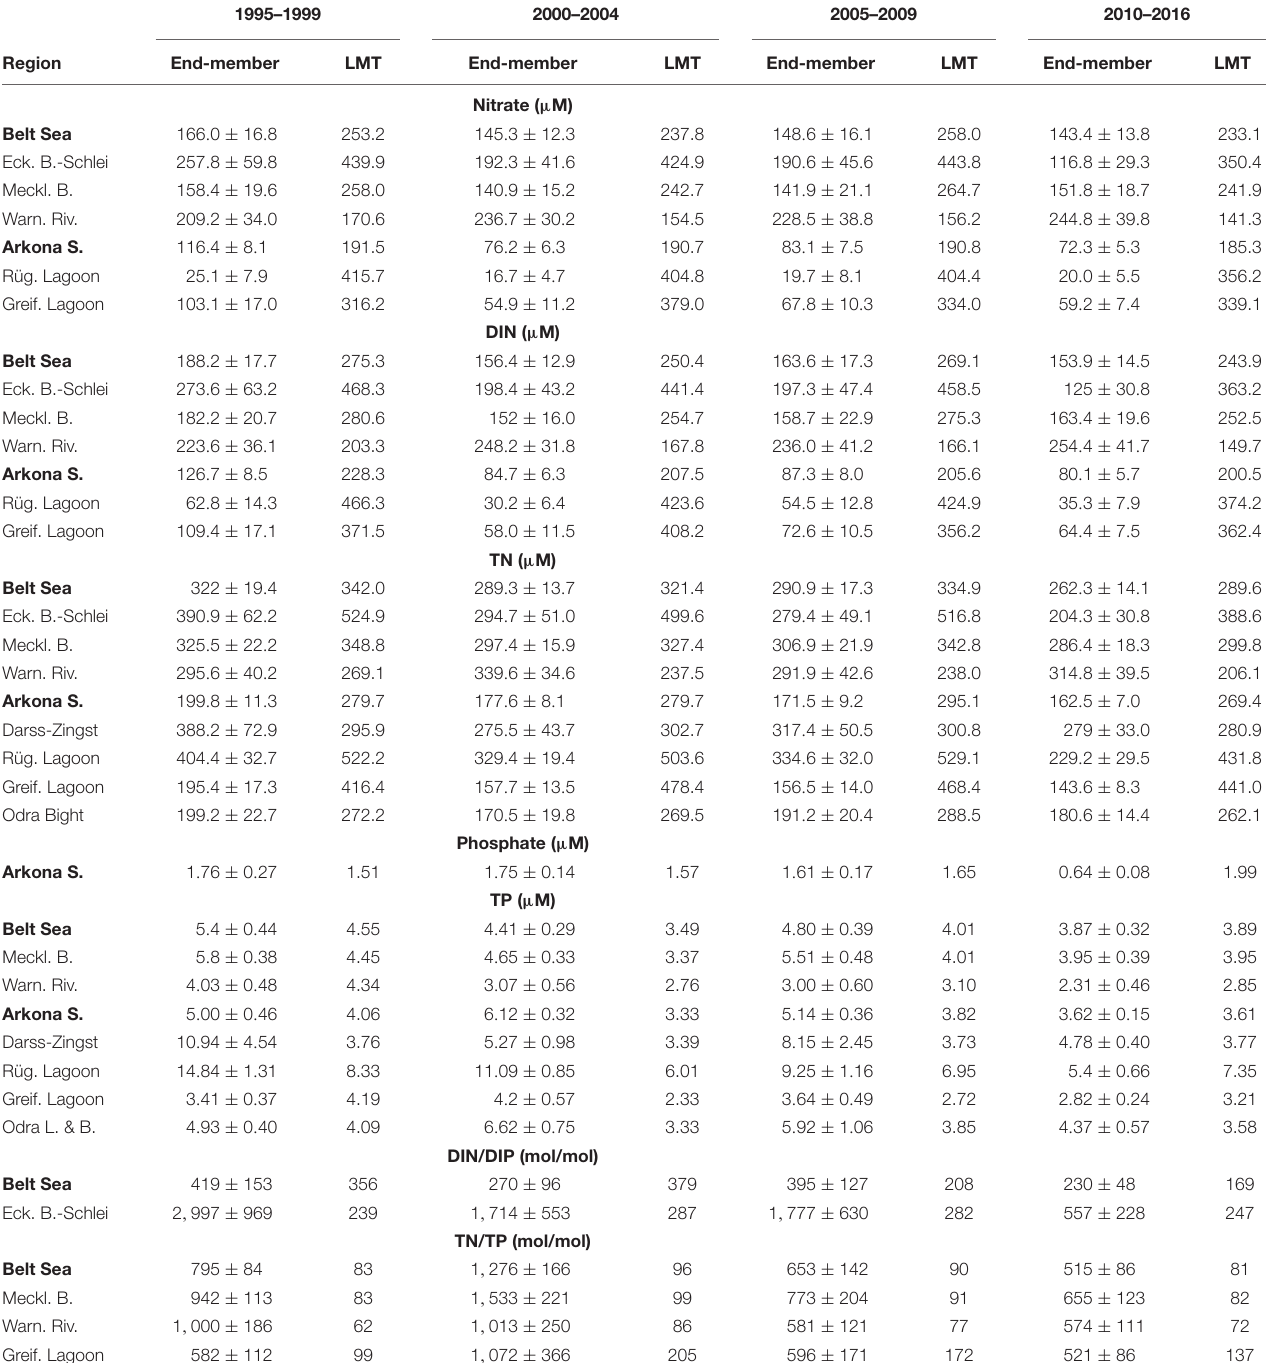
TABLE 1 | Freshwater end-members ( y -axis intercepts) from regression lines of parameter–region pairs for all four investigated time periods with > 99% significance, the range ( ± ) of the 95% confidence interval, and average measured values for the limnic–marine transition (LMT) given for